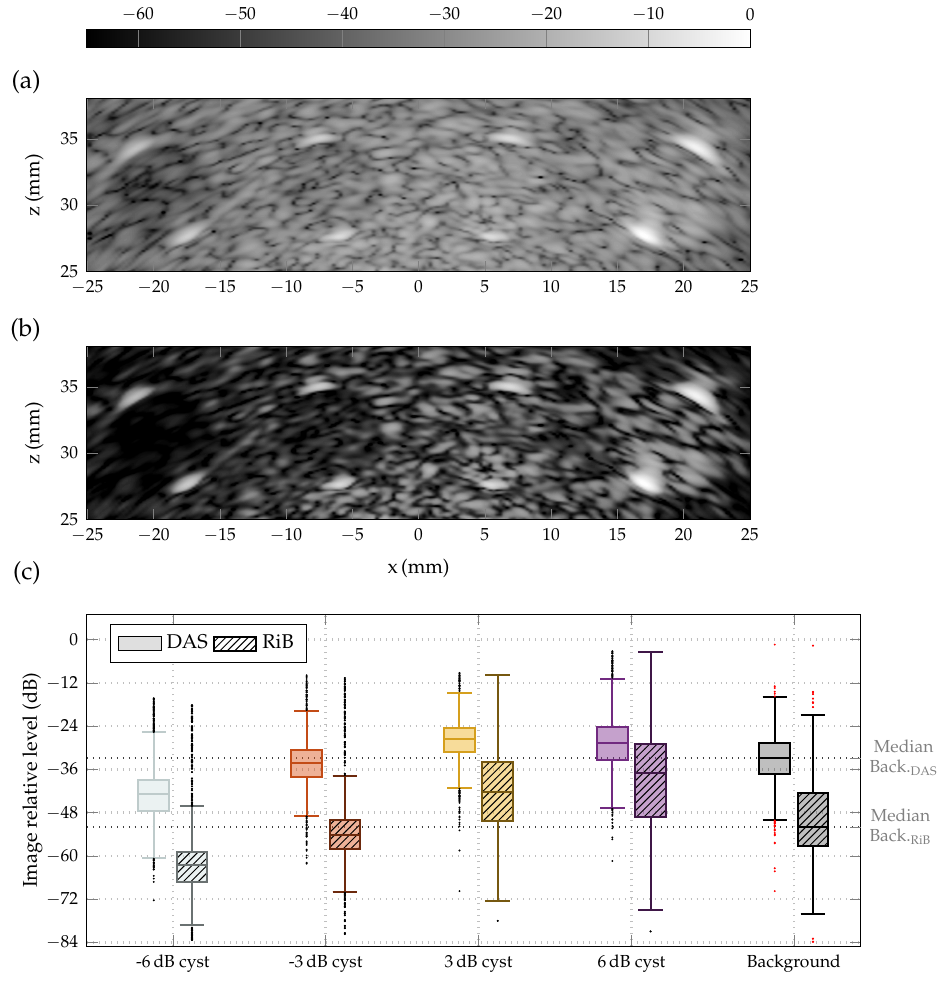
Figure 5. Results obtained using Array A of a CIRS 040GSE phantom. ( a )DAS, ( b )Rib10% and ( c )comparative